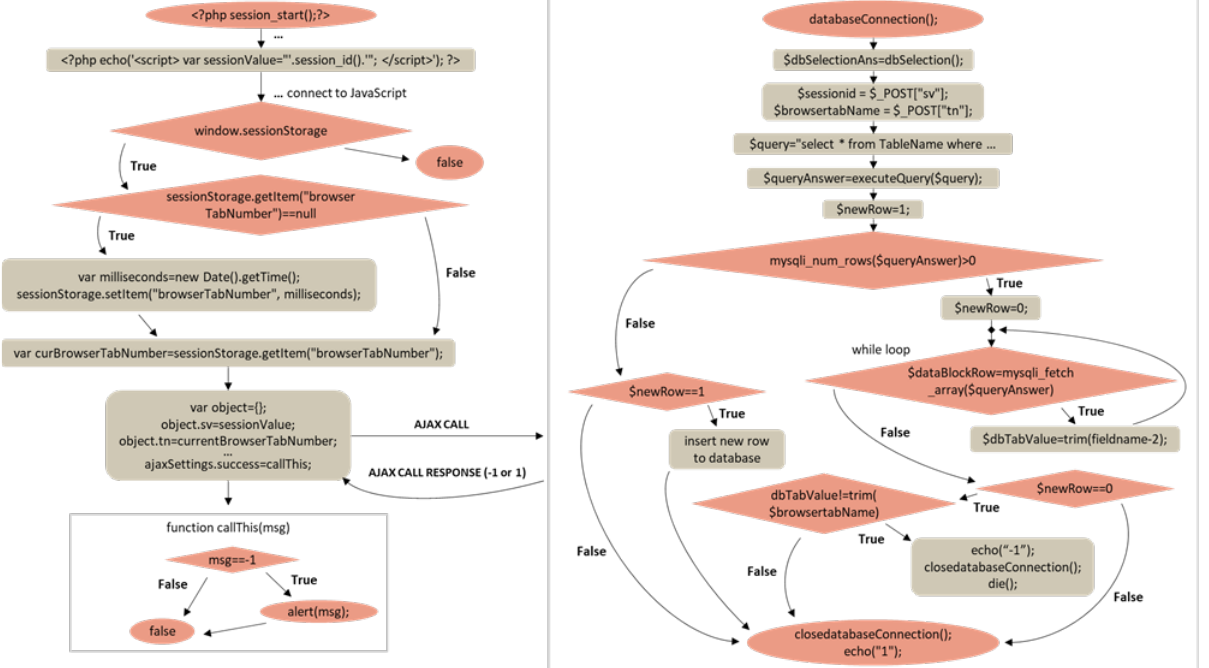
Figure 5. PHP & JavaScript source code logic for terminating a 2nd instance of the application at the same